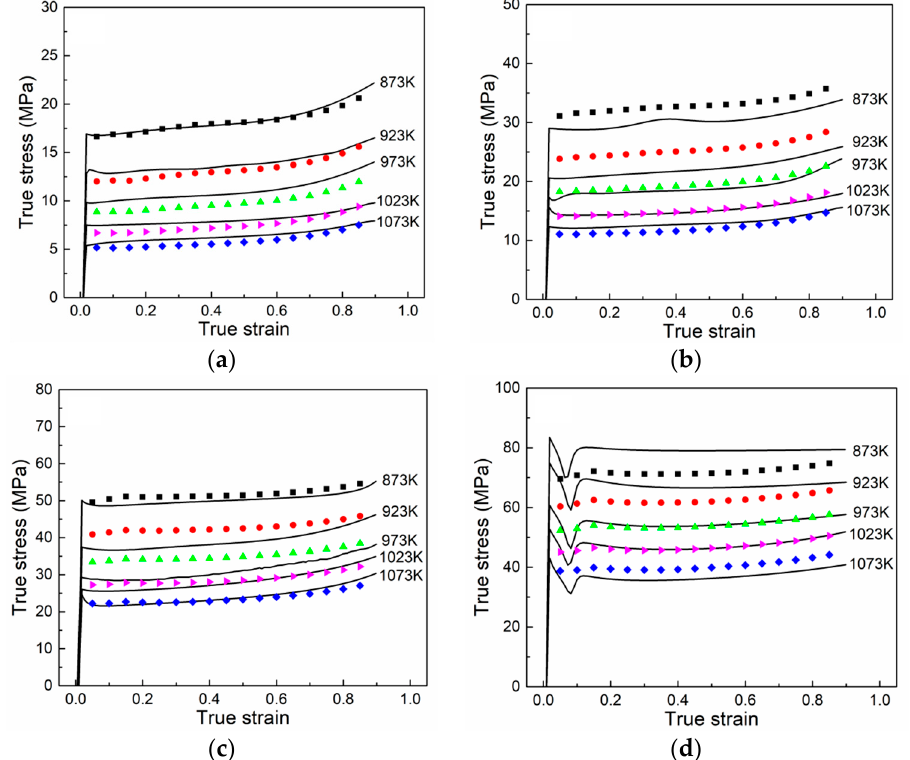
Figure 5. Comparison of experimental (black line) and predicted (dots) values under strain rates of ( a ) 0.01 s − 1 , ( b ) 0.1 s − 1 , ( c ) 1 s − 1 , ( d ) 10 s − 1 .